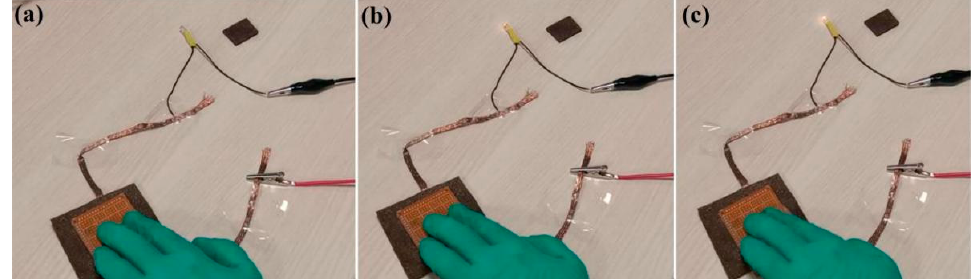
Figure 11. Flexible switch applications: ( a ) unpressed, ( b ) partly pressed, and ( c ) completely pressed.